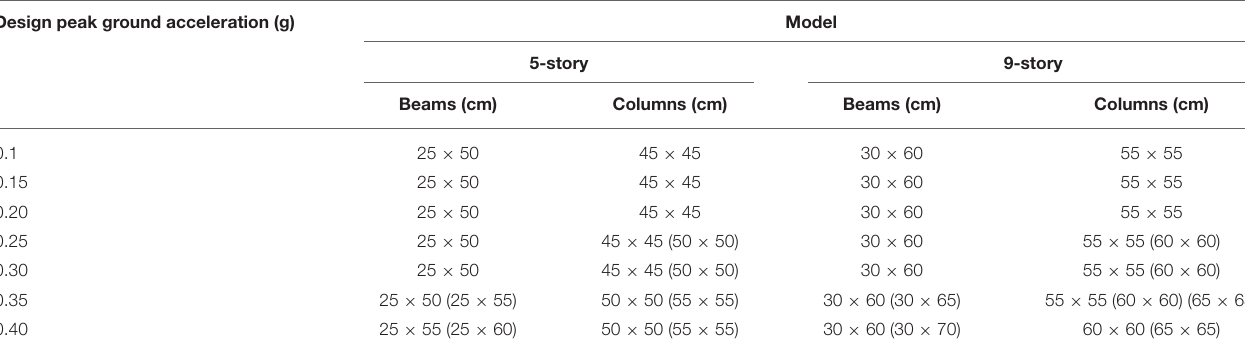
TABLE 1 | Cross sections of the structural elements (the cross-sectional dimensions outside the brackets correspond to sites with control period T C = 0.7s, while the values in brackets correspond to sites with longer control periods). Design peak ground acceleration